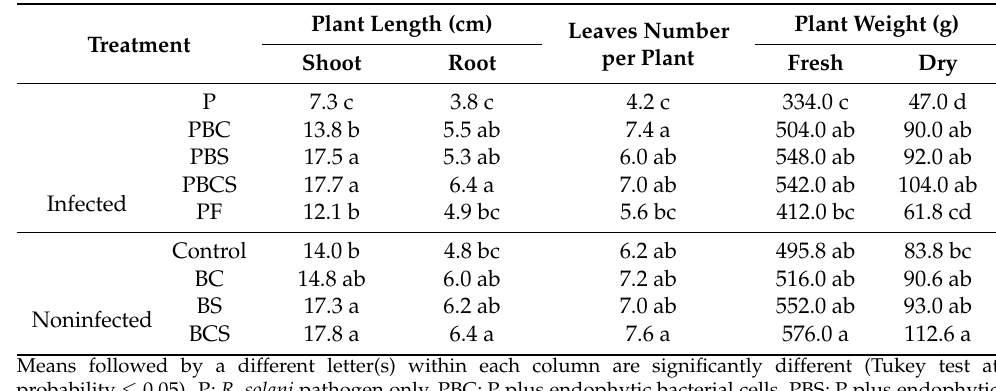
Table 5. Fenugreek growth as influenced by endophyte Achromobacter sp. F23KW treatments under greenhouse conditions.